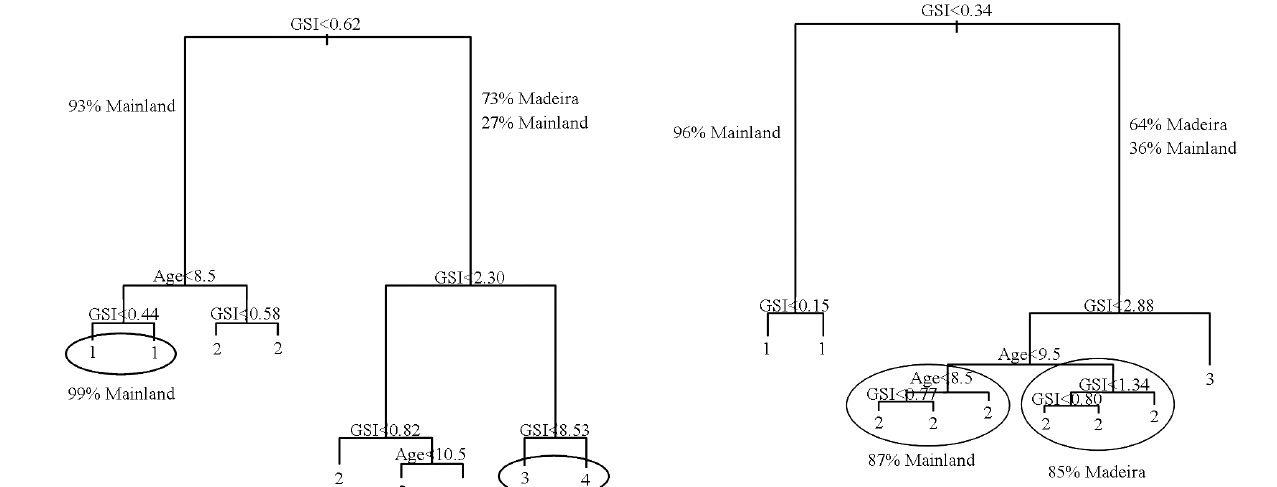
Fig . 11. – Application of the regression tree to male Aphanopus carbo data (gsi, age and maturity). the numbers (1 to 5) at the end of the tree branches refer to the maturity stages. the oval shapes Fig . 10. – Application of the regression tree to female Aphanopus group the individuals from the same area (with percentage of correct carbo data (gsi, age and maturity). the numbers (1 to 5) at the end classification of the tree branches refer to the maturity stages. the oval shapes group the individuals from the same area (with percentage of correct classification indicated).